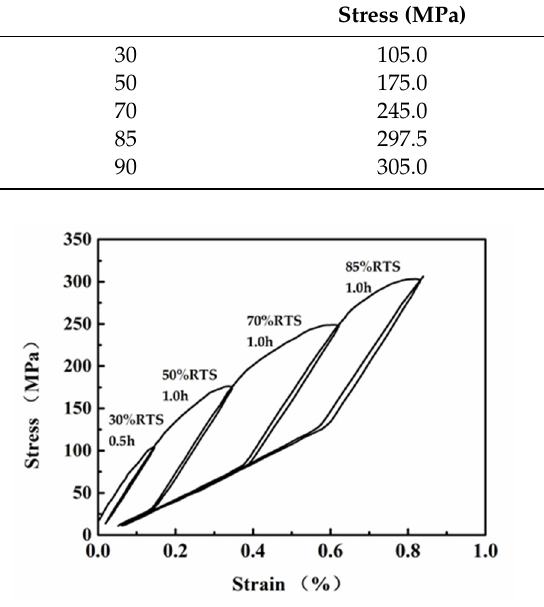
Figure 6. Stress-strain curve of ACCC/HW.